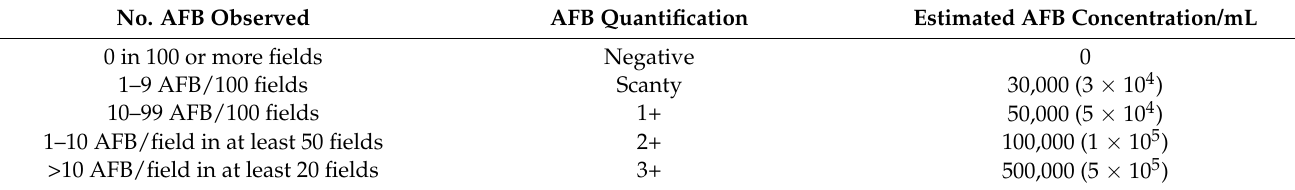
Table 1. AFB quantification guide and estimated AFB concentration per